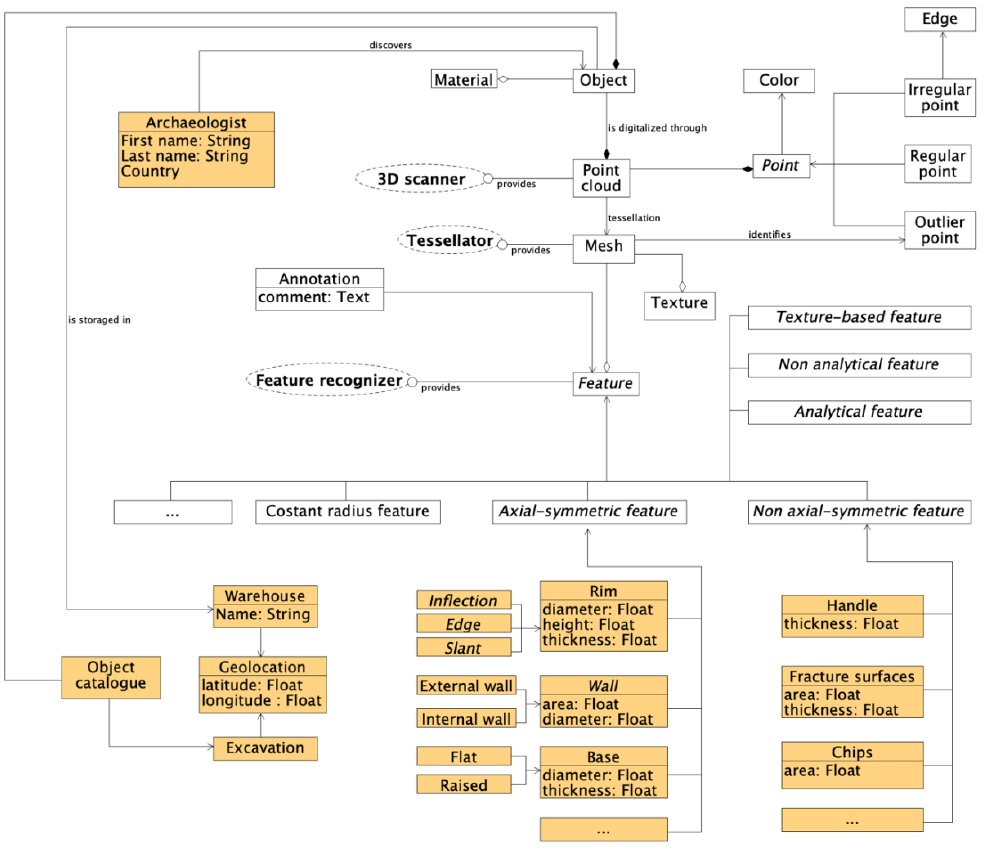
Figure 1. UML diagram of the database.